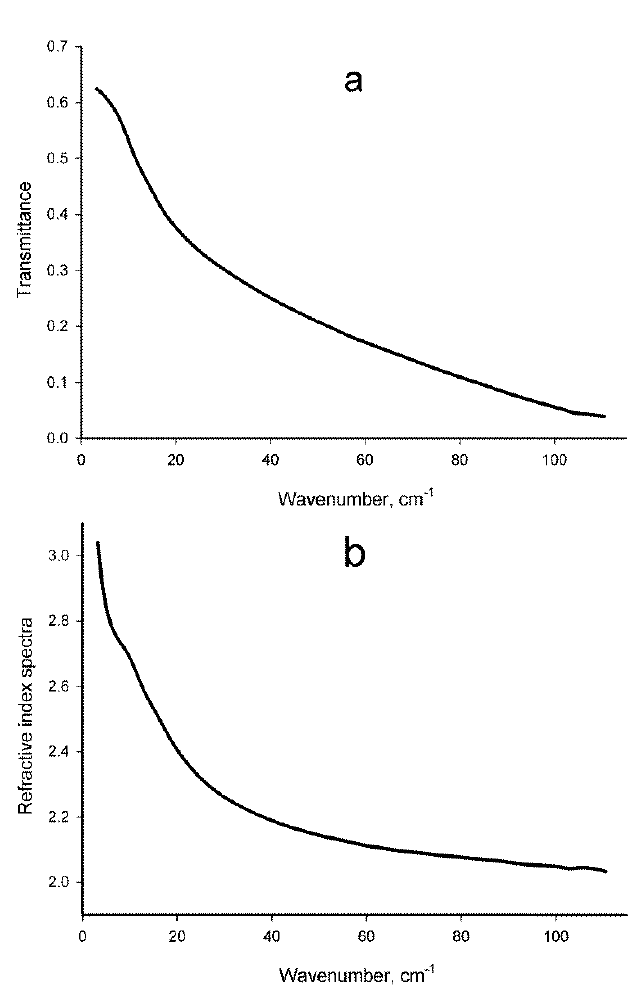
Figure 1. Representative transmittance ( a ) and refractive index ( b ) spectra of aqueous solutions of the Intact lactose sample.